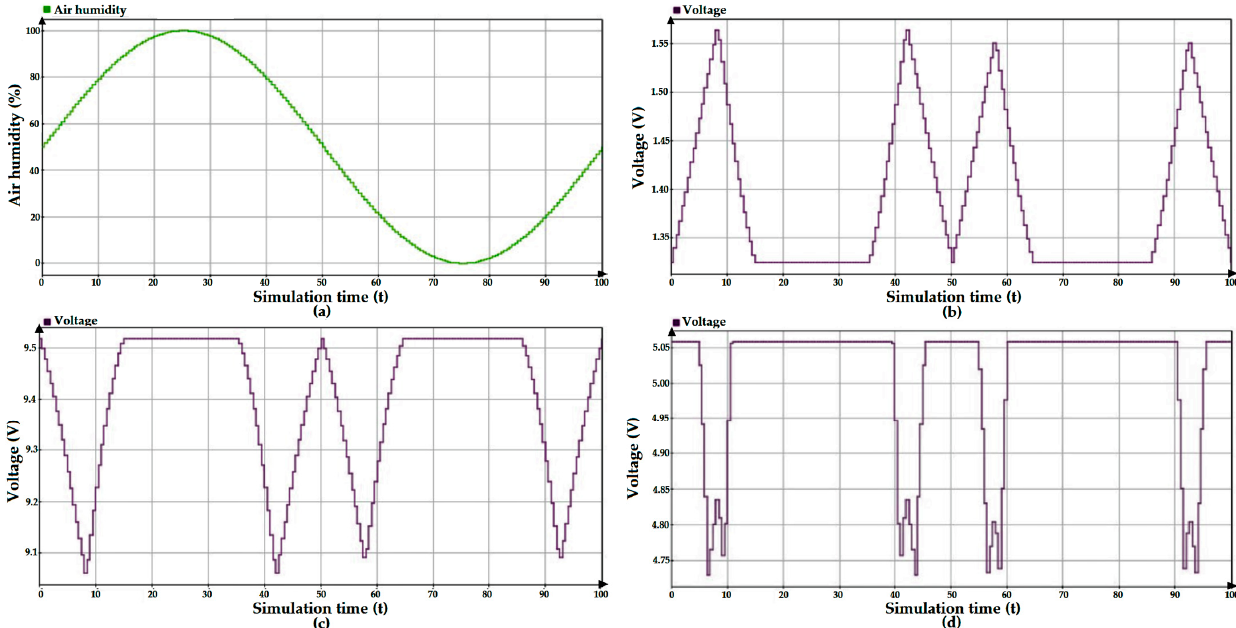
Figure 15. ( a ) Air humidity vs time; ( b ) voltage vs time at minimum water need; ( c ) voltage vs time at maximum water need; ( d ) voltage vs time at standard operating conditions.